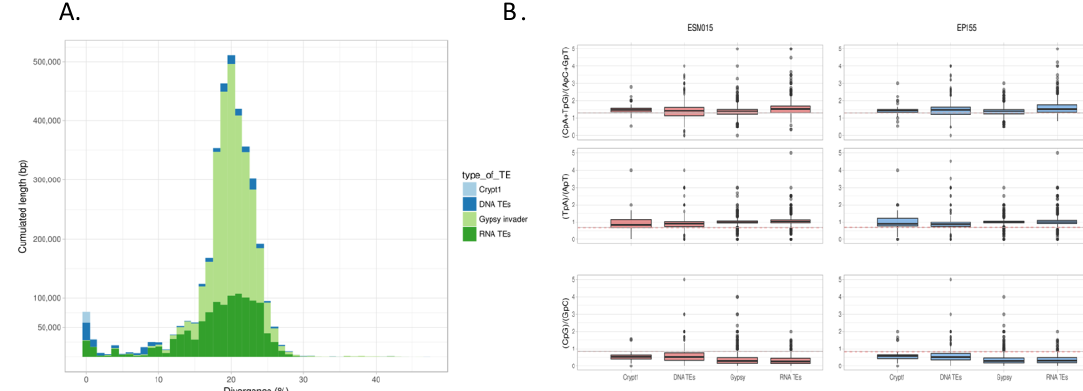
Figure 3 . Transposable elements (TEs) landscape of the ESM015 and EP155 genome. A. Nucleotidic divergence of TEs copies to their consensus, grouped by type of TEs. B. Inference of the signature of the repeat induced point (RIP) mutation. Three estimated indices are presented (CpA+TpG)/(ApC+GpT), TpA/ApT and CpG/GpC (see text for details). The dashed red line indicates the threshold values obtained from the genomic sequences without TE for the corresponding genome (ESM015 or EP155). Confidence intervals at 99.9% for the threshold values are indicated in